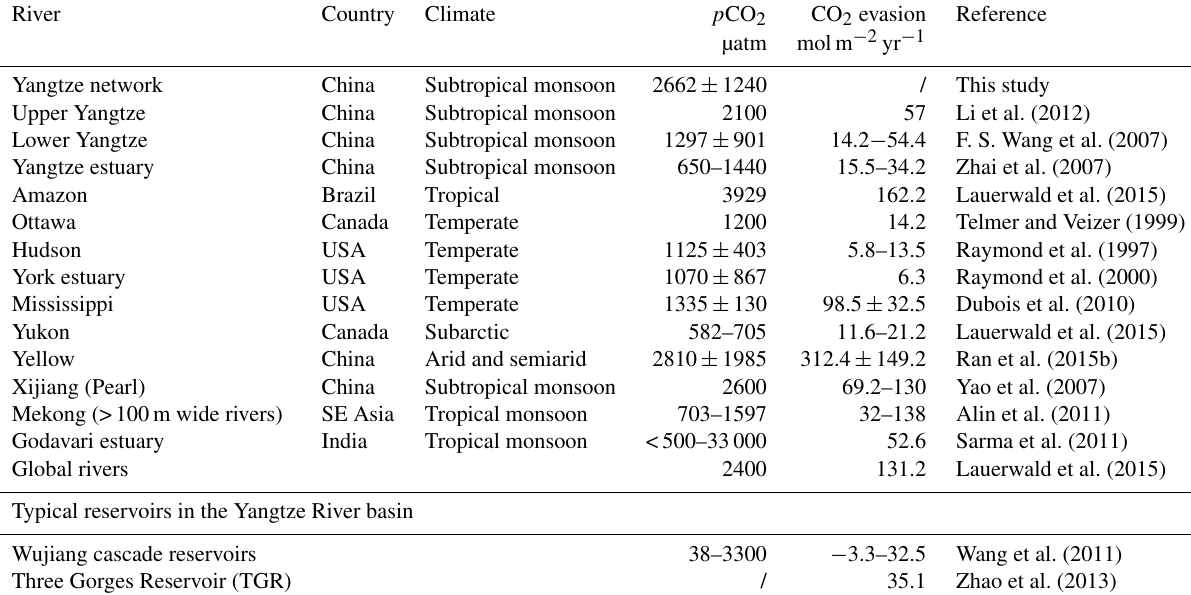
Table 4. Comparison of p CO 2 and CO 2 evasion among world large rivers and typical reservoirs in the Yangtze River basin.